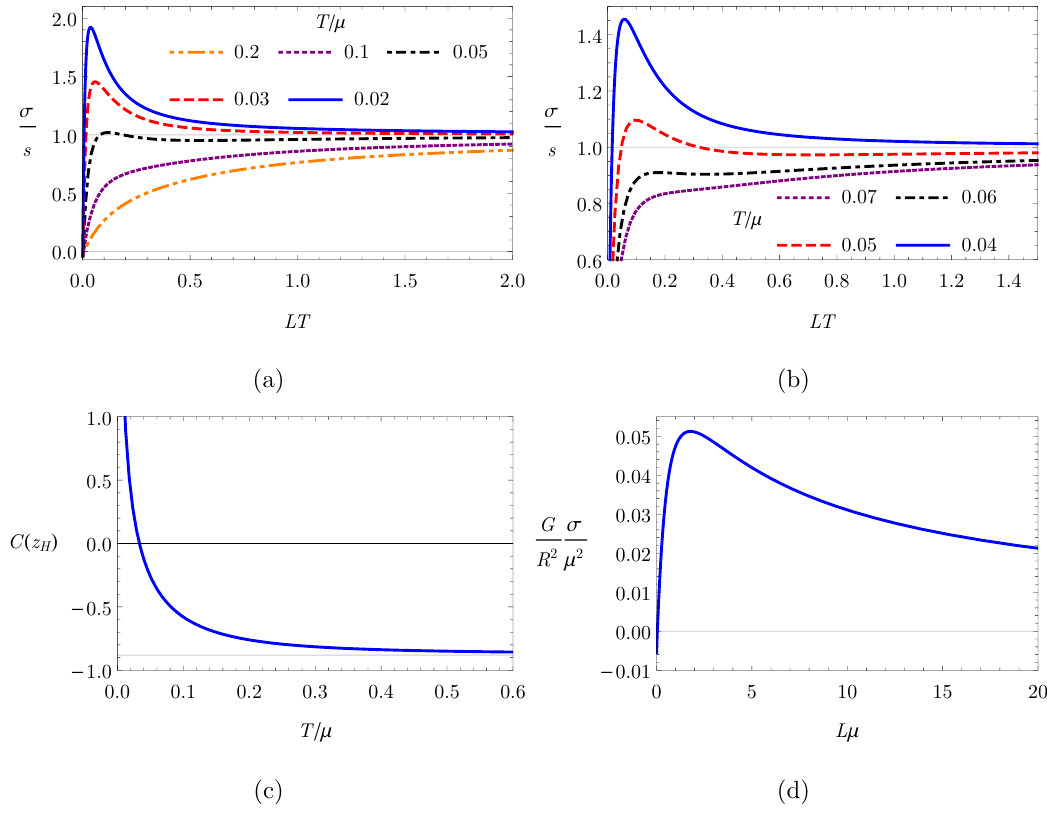
Figure 15. Plots of our results using the solution given by eq. (6.11) ( d = 3, (cid:16) = 3, (cid:18) = 1). (a) The ED, (cid:27) , in units of entropy density s , for the strip, for T=(cid:22) = 0 : 2 down to 0 : 02. (b) Close-up of (a), showing the formation of a local maximum and minimum before the formation of the global maximum as T=(cid:22) decreases from 0 : 07 down to 0 : 02. (c) The dimensionless coe(cid:14)cient C ( z H ) from eq. (2.23) versus T=(cid:22) . As T=(cid:22) ! 1 , C ( z H ) approaches the value for AdS-SCH with d = 3 (the horizontal line). As T=(cid:22) decreases, C ( z H ) changes sign from negative to positive at the ( T=(cid:22) ) 3 from table 4, indicating area theorem violation when T=(cid:22) < ( T=(cid:22) ) 3 . (d) The ED, (cid:27) , in units of (cid:22) 2 R 2 =G , versus L(cid:22) , at T=(cid:22) = 0. The global maximum and area theorem violation remain, albeit with the logarithmic area law violation in eq.